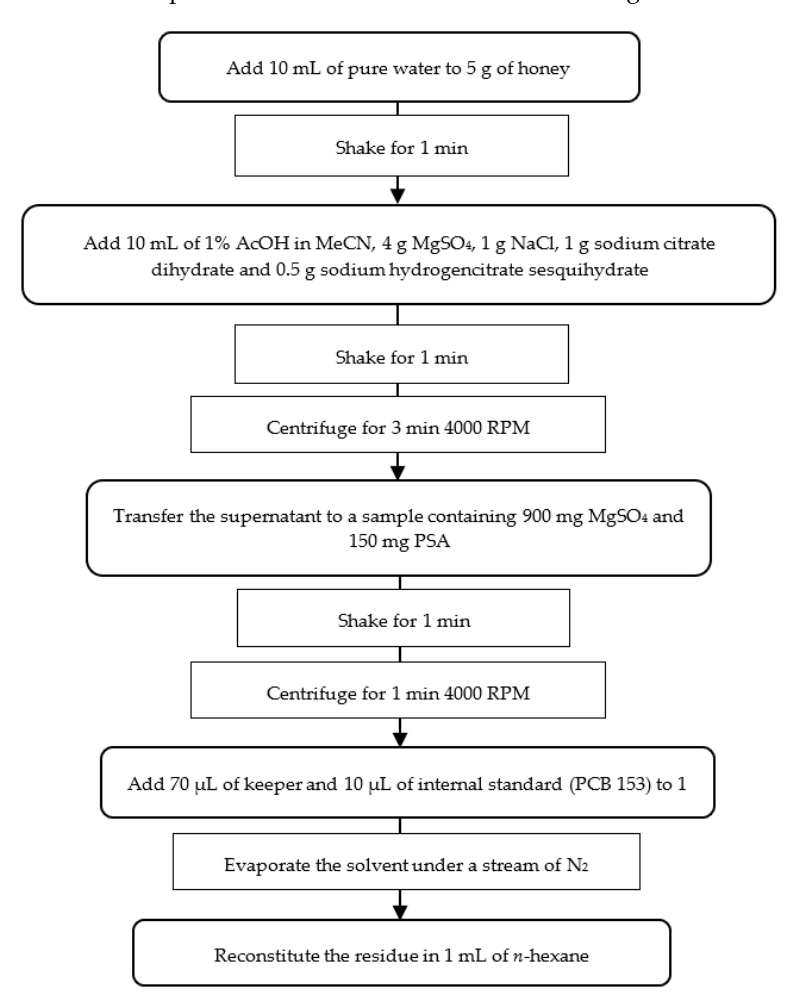
Figure 2. Extraction method used in the study.